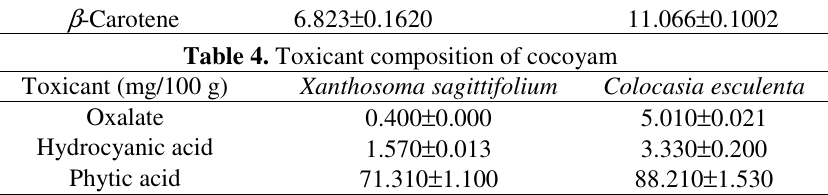
Table 4. Toxicant composition of